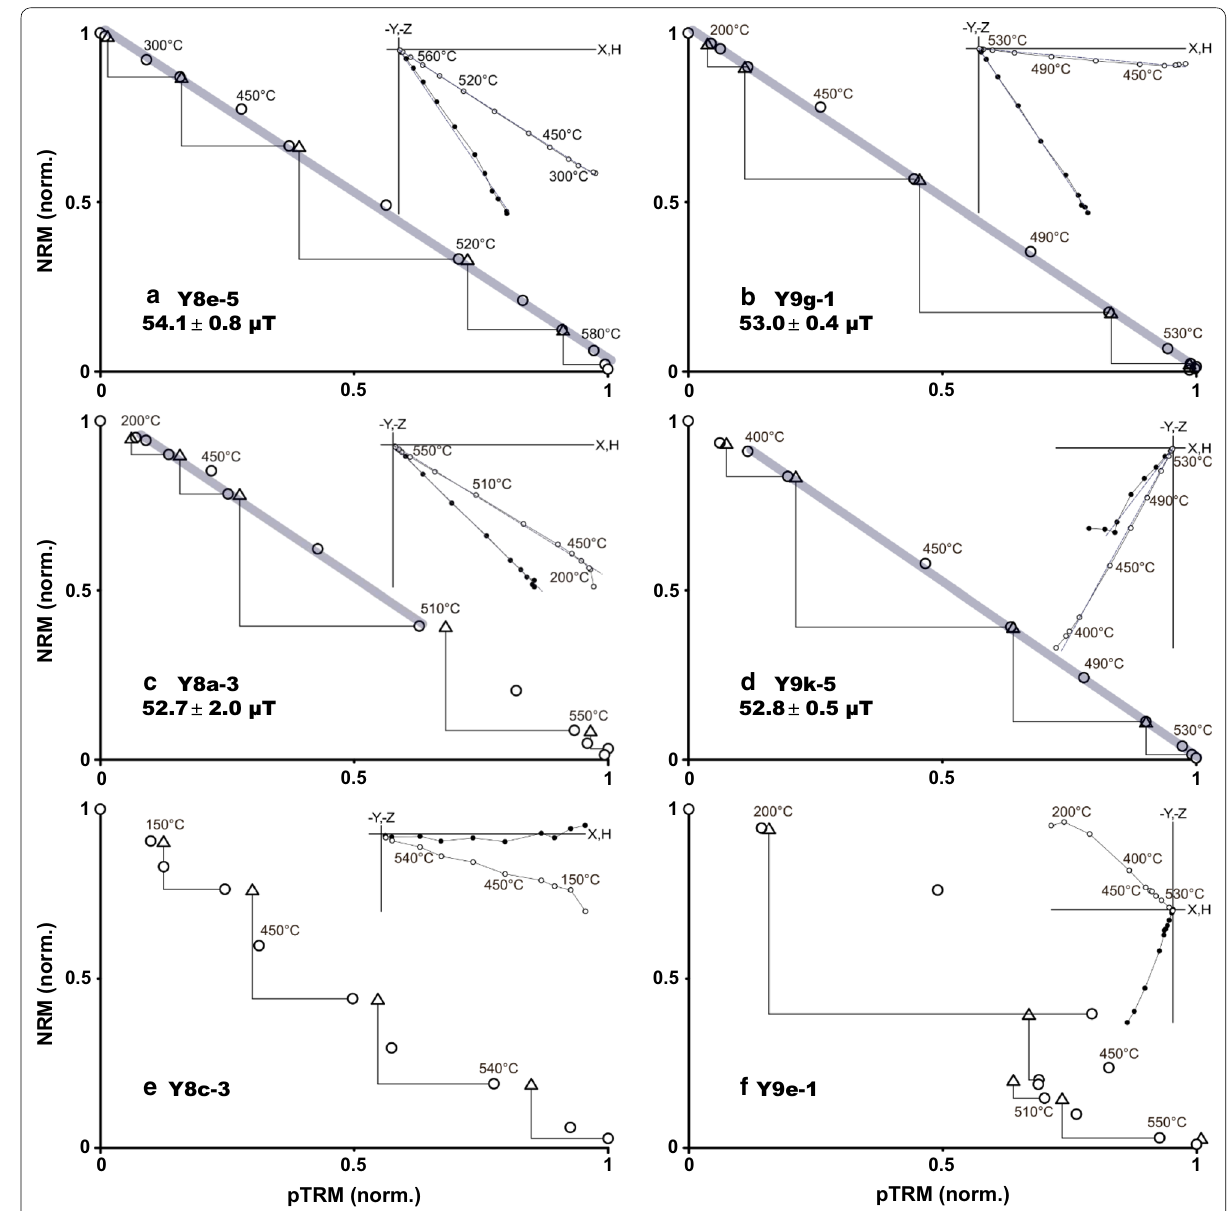
Fig. 5 Typical Arai plots of accepted ( a – d ) and rejected ( e , f ) specimens obtained from IZZI-Thellier experiments. Circles represent the normalized NRM vs. pTRM data with best-ft lines marked in gray. pTRM checks are shown as triangles. Zijderveld plots of the experiments are also shown as inset figures. Paleointensity analysis was conducted using ThellierTool (Leonhardt et al.